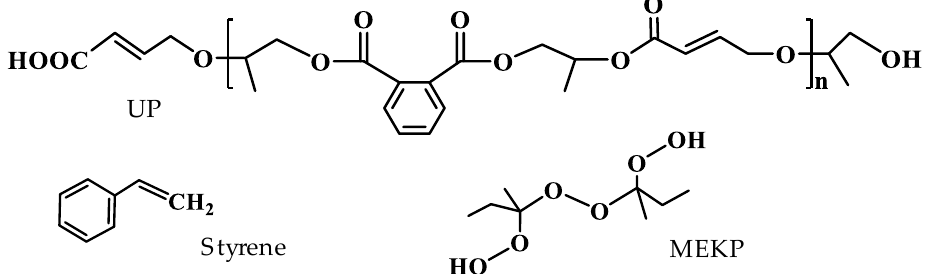
Figure 1. Molecular structures of UPR, styrene, and MEKP.